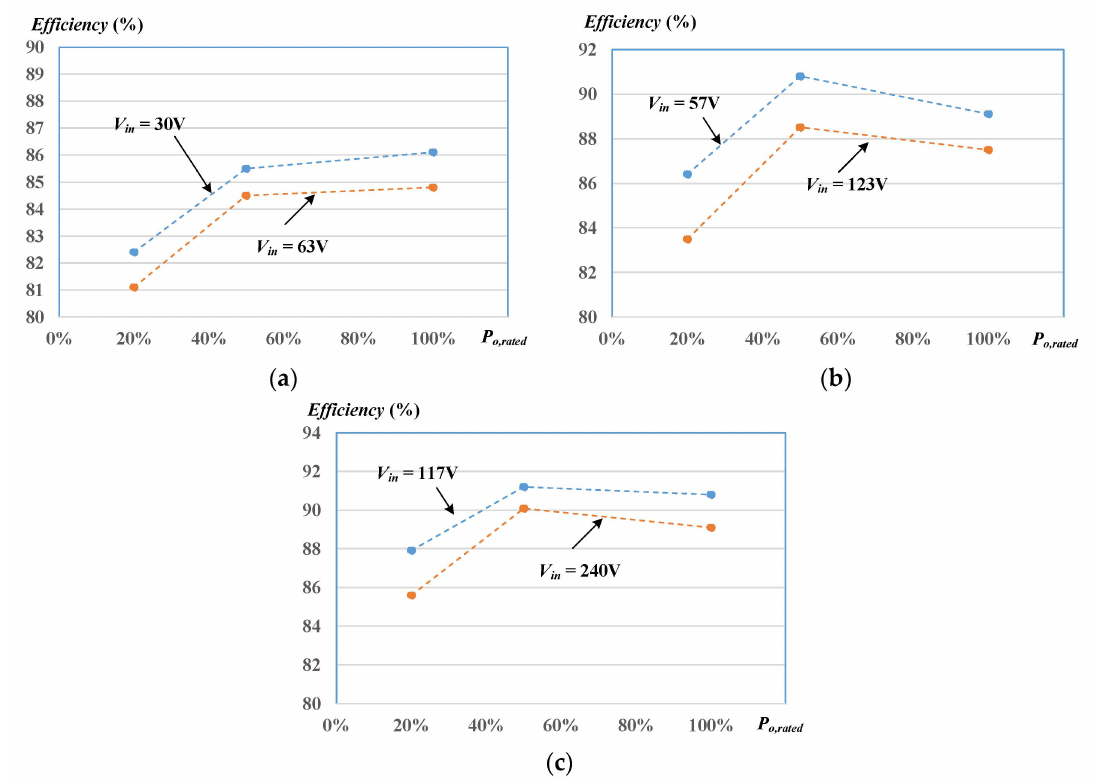
Figure 13. Circuit e ffi ciencies under ( a ) low voltage range ( V in = 30 V ~ 63 V), ( b ) medium voltage range ( V in = 57 V ~ 123 V), and ( c ) high voltage range ( V in = 117 V ~ 240 V).